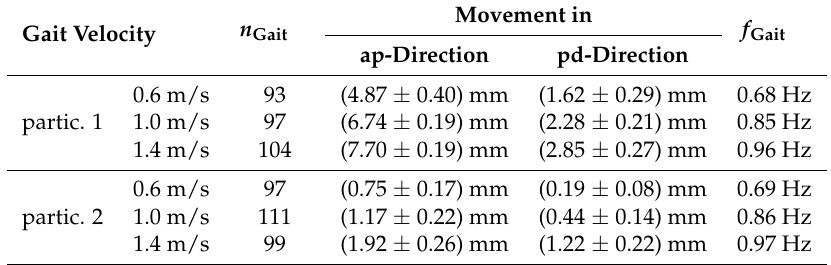
Table 4. Summary of sensor data analysis for gait on treadmill of participant 1 and 2 (cf.